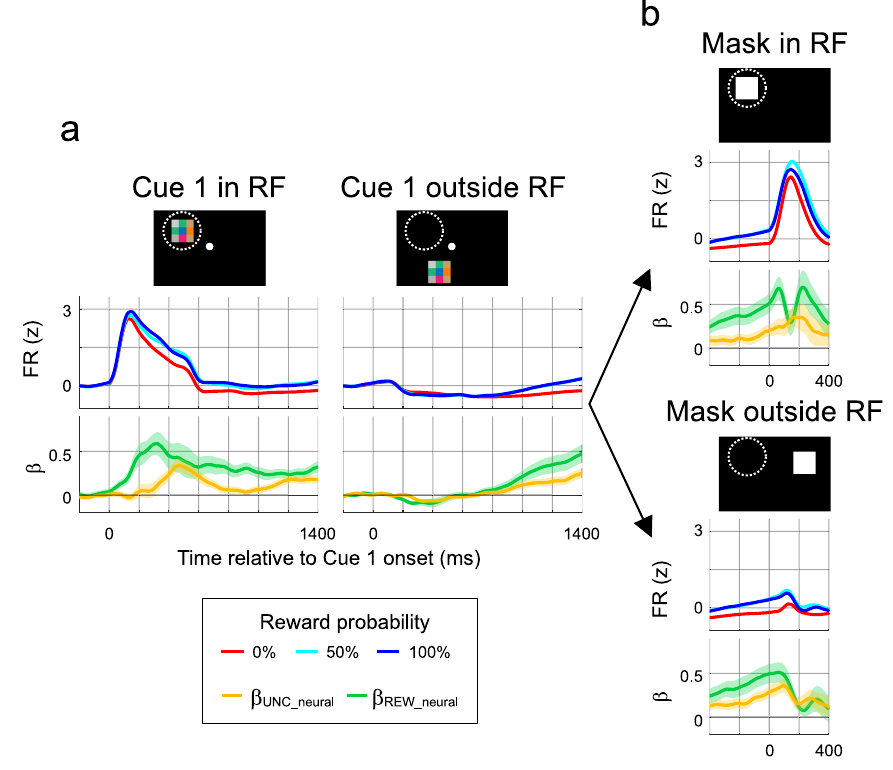
Fig.2|LIPmodulationsbyrewardanduncertainty.a ResponsesalignedtoCue1 onset. The cartoons show Cue 1 (colored checkerboard) appearing inside or out- side the RF (dashed circle). The middle row shows population peri-stimulus response histograms computed byz-scoring therawFRwithineachneuron(using allofitsdatainthetask),averagingacrosstrialswithineachneuron,andaveraging acrossneurons( n =68).Thebottompanelsshowregressioncoef fi cientsindicating the effects of uncertainty ( β UNC_neural , yellow) and reward ( β REW_neural , green). The